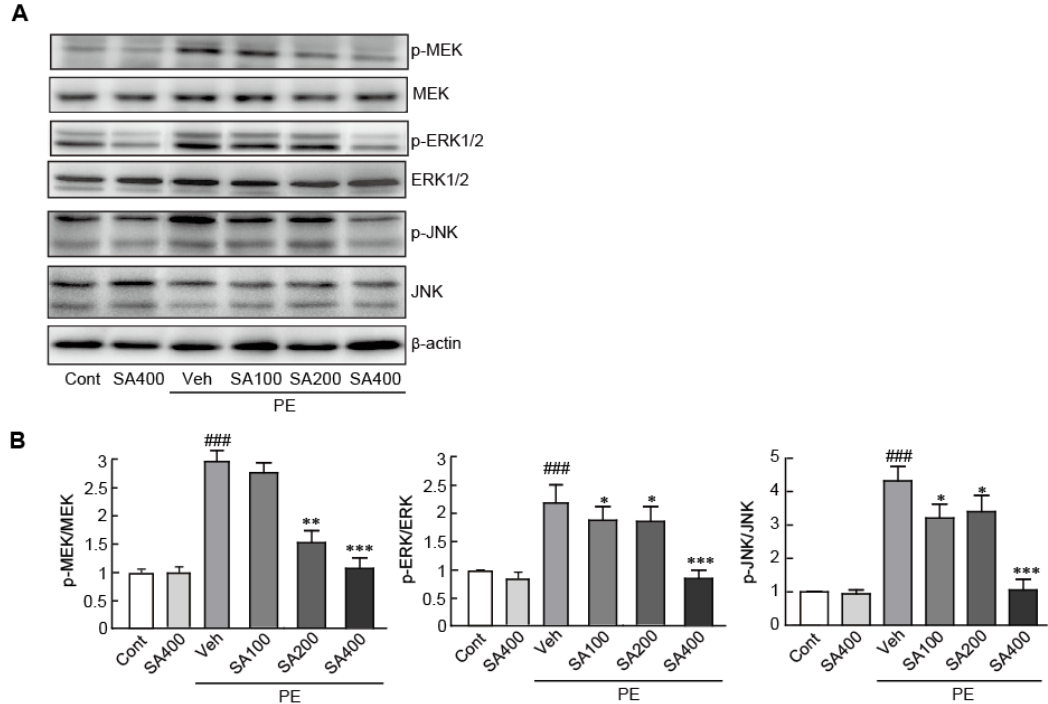
Figure 3. SA inhibits MAPK signaling in PE-induced hypertrophic cardiomyocytes. ( A ) The expression levels of total MAPK proteins (MEK, ERK1 / 2, and JNK) and phosphorylated forms of MAPK proteins (p-MEK, p-ERK1 / 2, and p-JNK) were measured by Western blot analysis. ( B ) The band densities were measured by using NIH ImageJ software. β -actin was used as a loading control. The analyses were performed in triplicate, using three independent samples. Data are expressed as the mean ± standard error of the mean (SEM). Significance was assessed by one-way analysis of variance (ANOVA) with a Bonferroni post hoc test. ### P < 0.001 vs. the control group; * P < 0.05 and ** P < 0.01, and *** P < 0.001 vs. the PE-only treated group. Veh, vehicle-treated; SA100, SA200, and SA400, 100, 200, and 400 µ M SA-treated groups, respectively; MEK, MAPK / ERK kinase; PE, phenylephrine; Cont, control; SA, sinapic